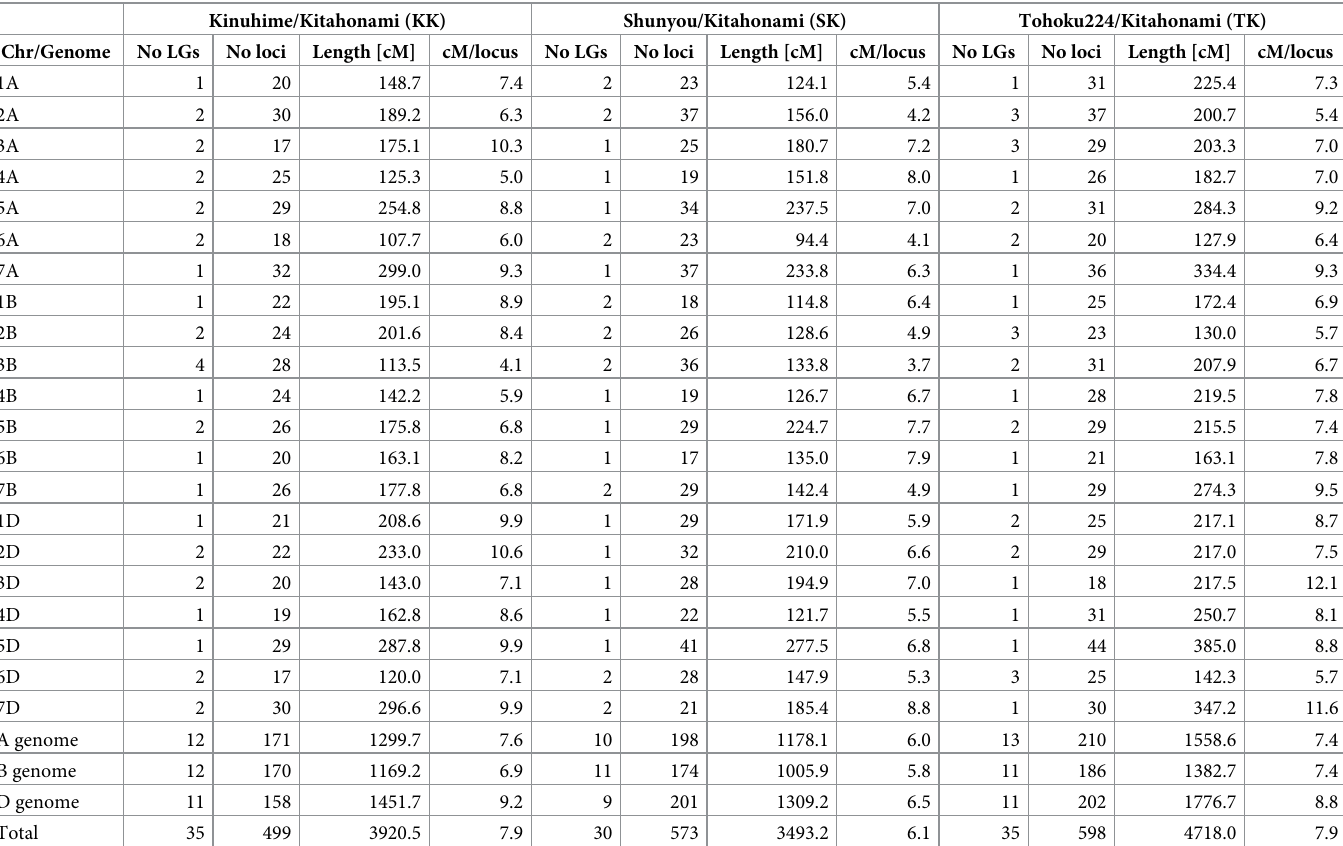
Table 1. Summary of linkage maps obtained using the three doubled haploid populations. Kinuhime/Kitahonami